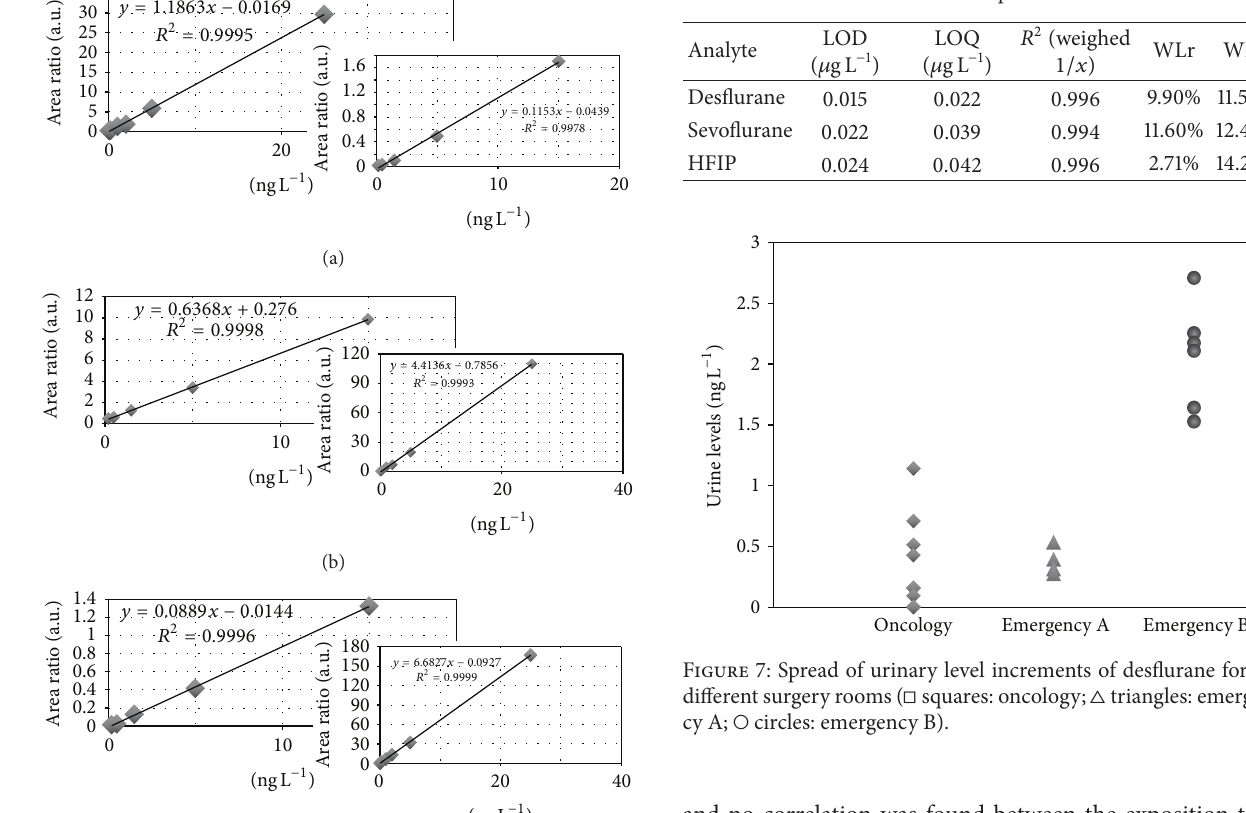
Table 2: Method performances.